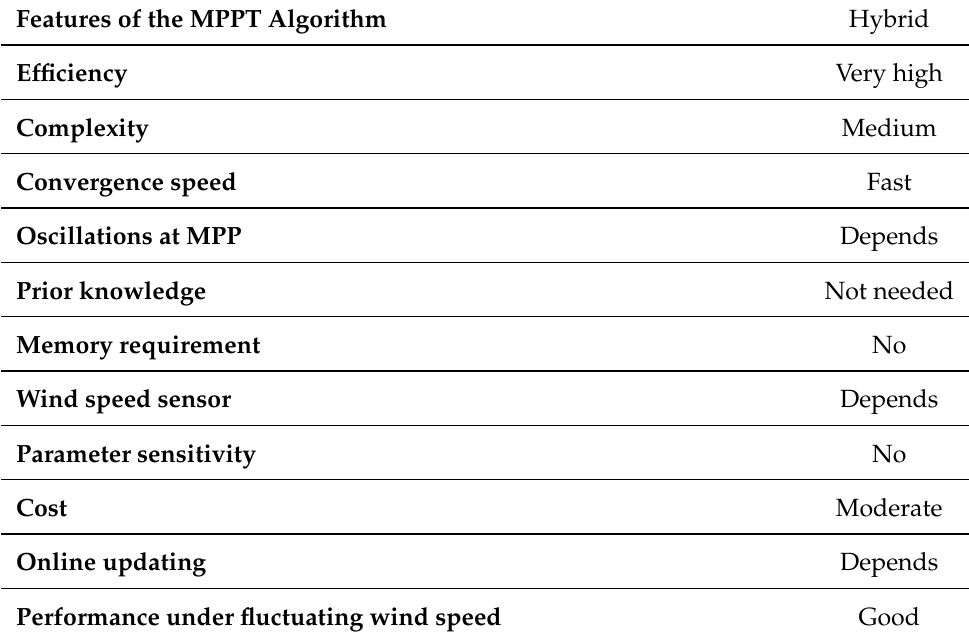
Table 9. Comparison of Hybrid MPPT Algorithms for WECS. Reused with permission